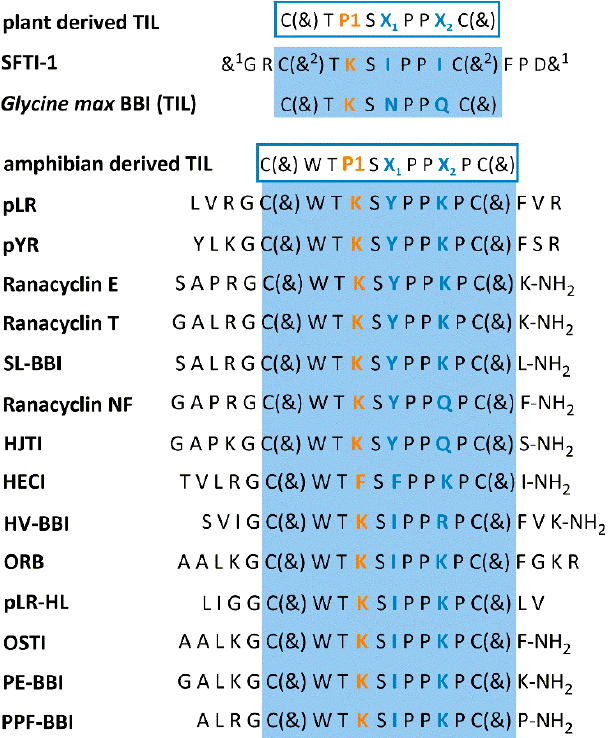
Figure 1. The comparison of trypsin inhibitory loops (TILs) of amphibian-derived BBLTIs and representatives of plant-derived BBIs ( Glycine max BBI and SFTI-1). P1 position is marked in orange, and variable X 1 and X 2 positions are marked in blue. The conserved disulfide loop of amphibian BBLTIs is highlighted in blue.